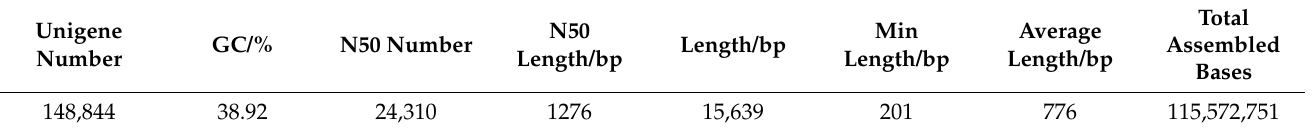
Table 2. Transcriptome analysis data statistics of C. vietnamensis